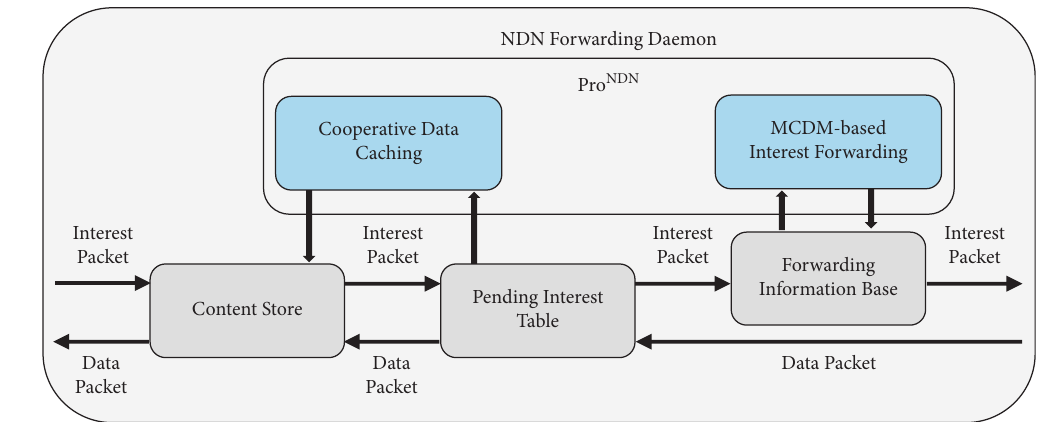
Figure 3: Architecture of Pro NDN . Table 1: Notations. Table 2: Decision matrix for interface alternatives.